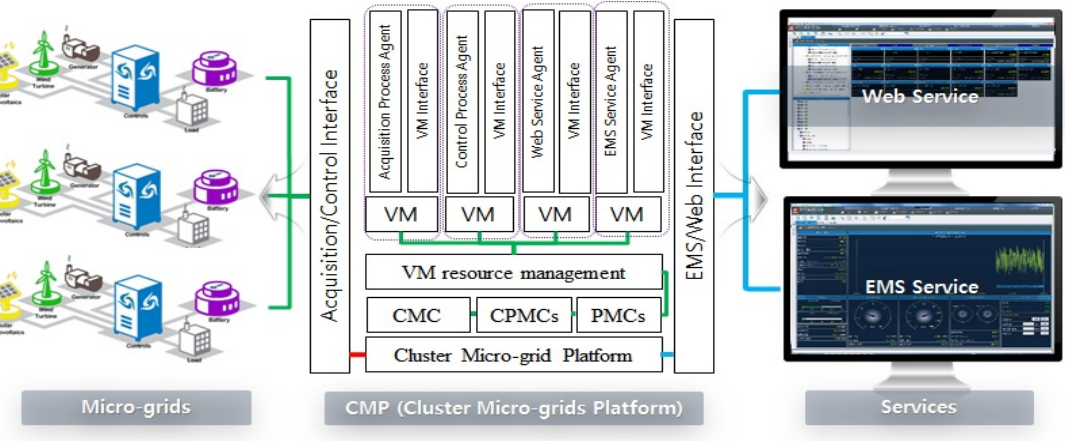
Figure 1. Configuration of a large-scale distributed system, along with VMG, and Web/EMS ser- vice.